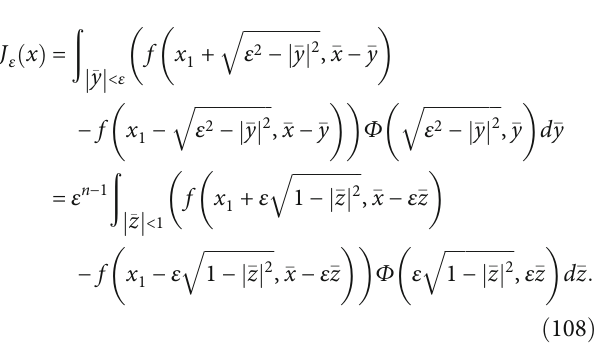
ffiffiffiffiffiffiffiffiffiffiffiffiffiffiffiffi